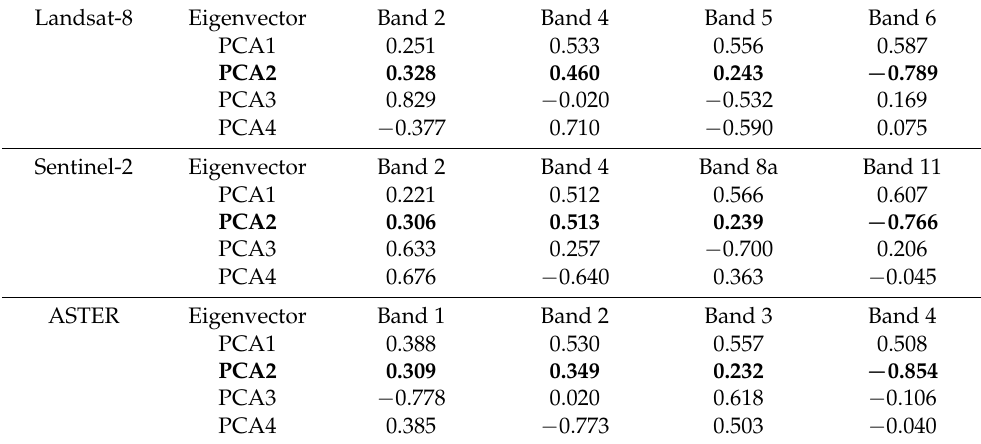
Table 6. The eigenvector matrixes of PCA results for mapping iron oxide minerals using different remote sensing data; Bold text represents the selected PCA and the unique eigenvalues.